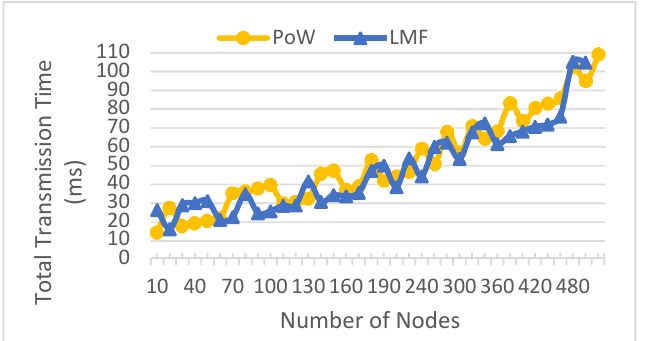
Figure 16. The total transmission time vs. the number of nodes on the PoW and LMF models.